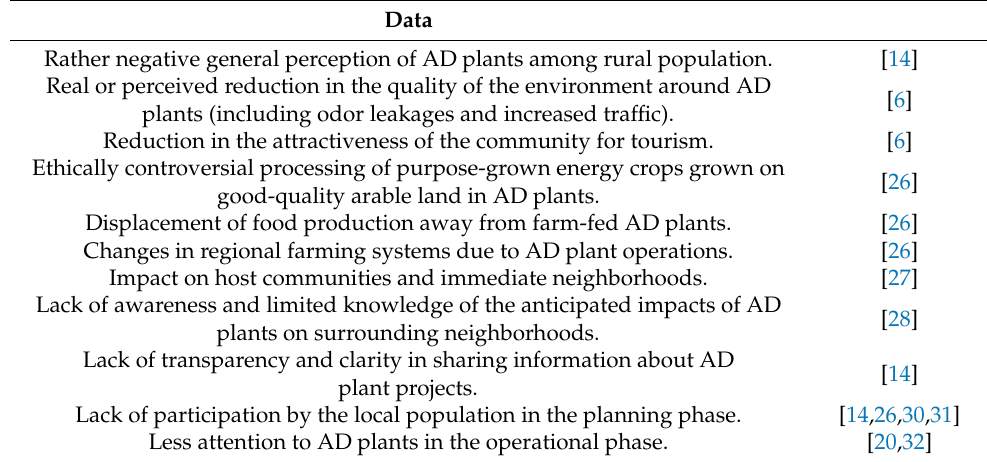
Table 1. Key factors affecting the perception of AD plants.